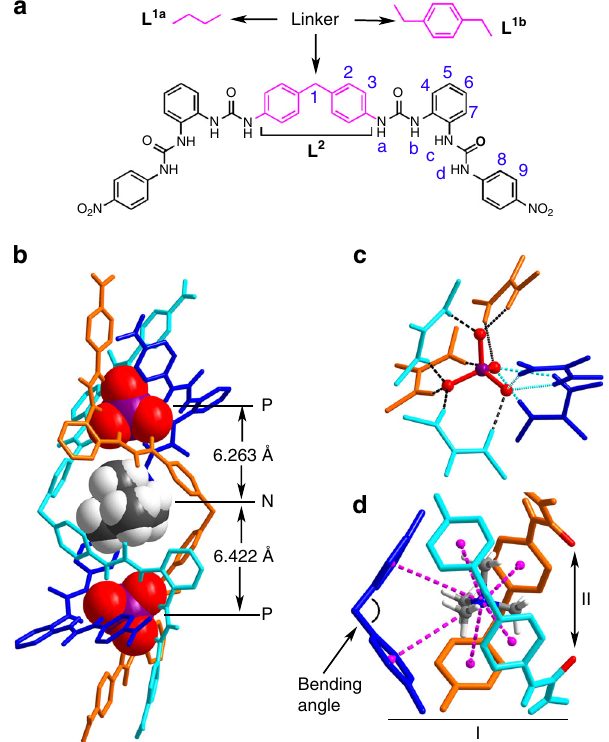
Fig. 1 Structure of a ChoX-mimicking triple anion helicate receptor. a Structures of bis-bisurea ligands L 1a , L 1b , and L 2 that can readily form the A 2 L 3 (A = anion, L = ligand) triple helicates when coordinated with PO 4 3 − ions. b Crystal structure of complex 1 , (TMA) 5 [(TMA) ⊂ (PO 4 ) 2 ( L 2 ) 3 ] ( ⊂ = encapsulated by; only an M enantiomer is shown; other counter cations, solvent molecules, and non-acidic protons are omitted for clarity); c Hydrogen bonds formed between a PO 4 3 − ion and six urea units; d The aromatic box (site-I) trapping a TMA + through cation – π interactions (purple-dashed lines) and a potential hydrogen-bonding site (II), which together resembles the structure of Ch + ⊂